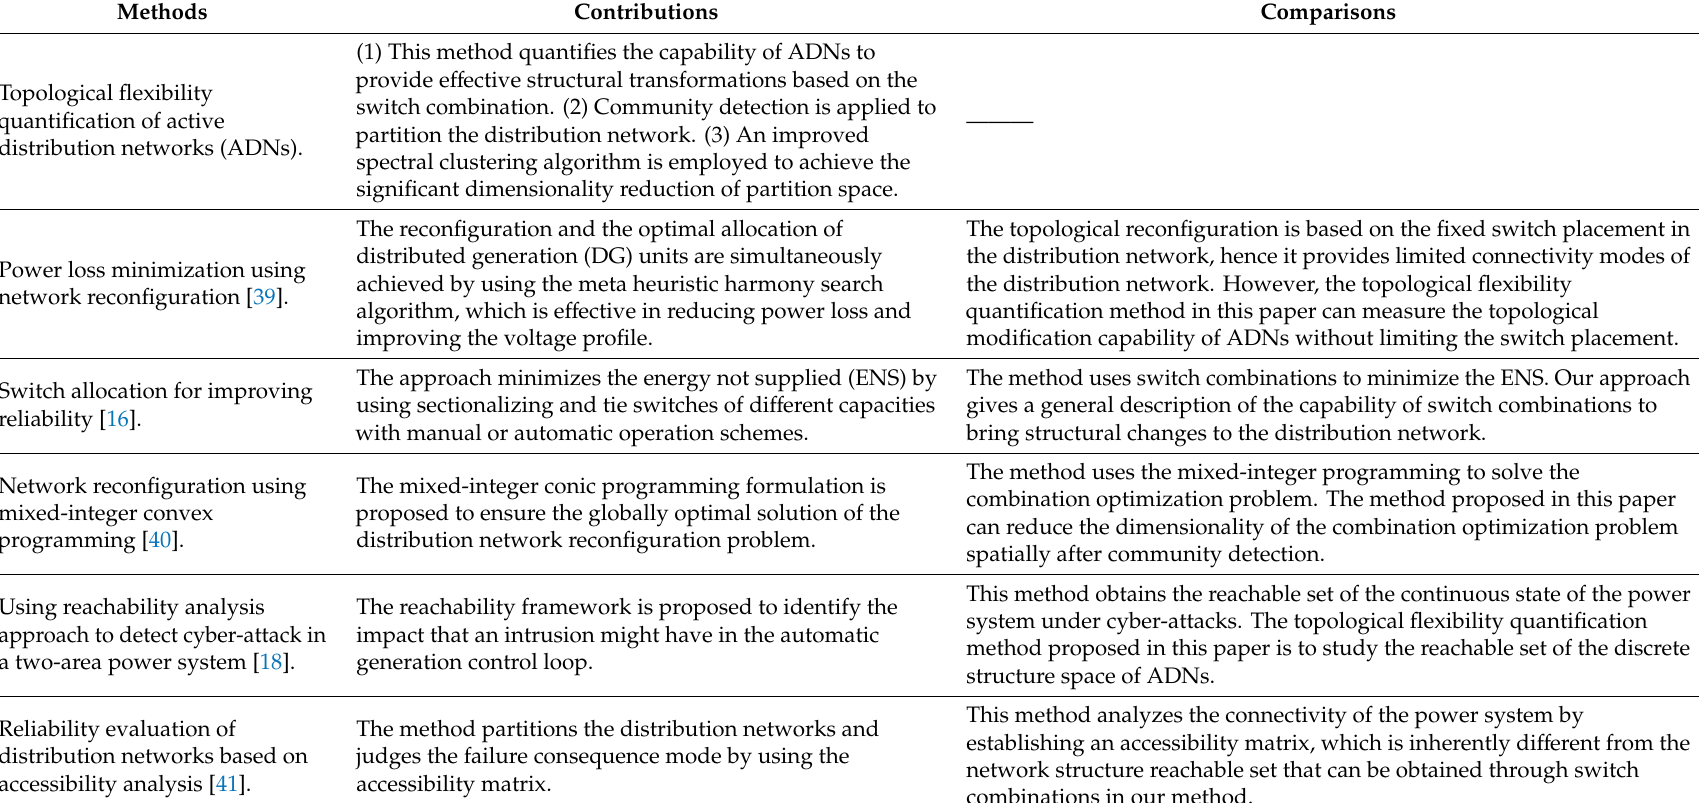
Table 1. Comparisons with the state of the art